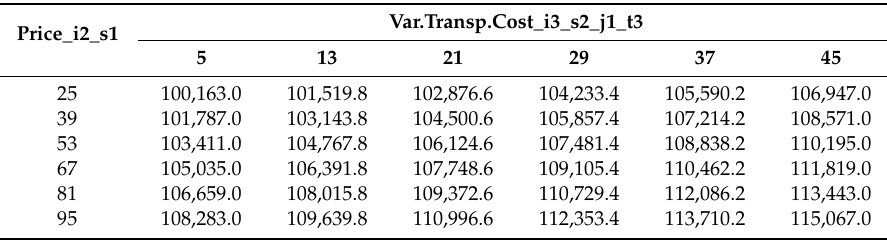
Table 2. Sensitivity analysis report of varying two parameters independently.